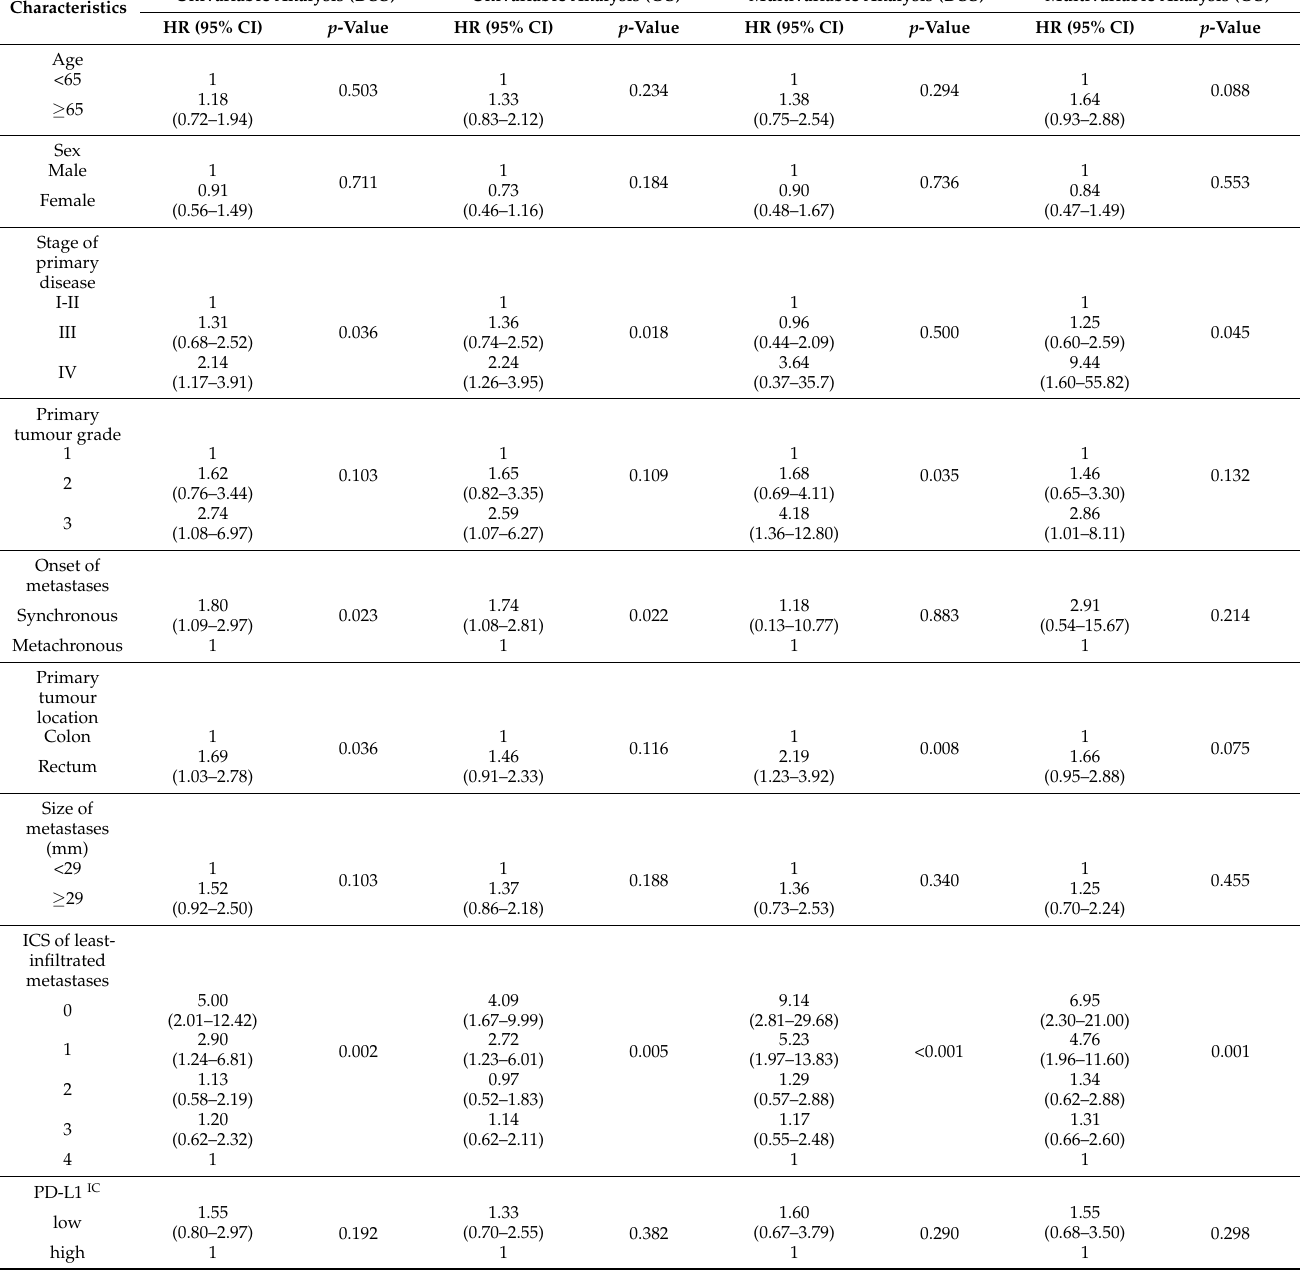
Table 3. Multivariable analysis with Cox proportional hazard